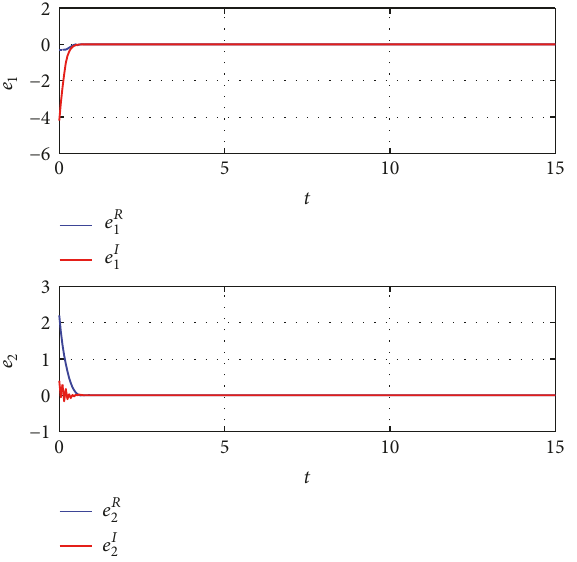
Figure 4: Time responses of synchronization errors 𝑒 1 and 𝑒 2 under controller for example 1.